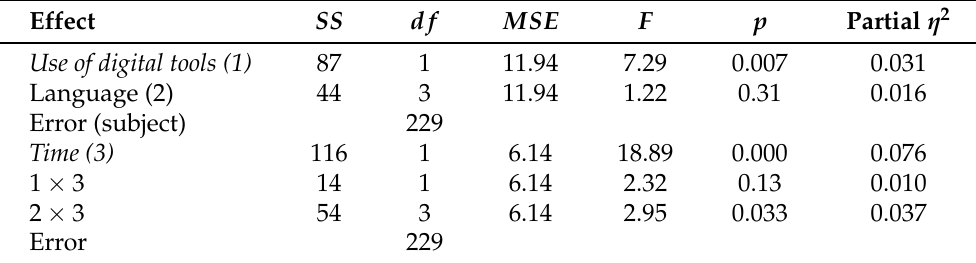
Table A13. Detailed report of the total score entered into a 2 (using digital tools, between-subjects) × 4 (language) × 2 (time, within-subjects) mixed factorial ANOVA. Significant effects are in